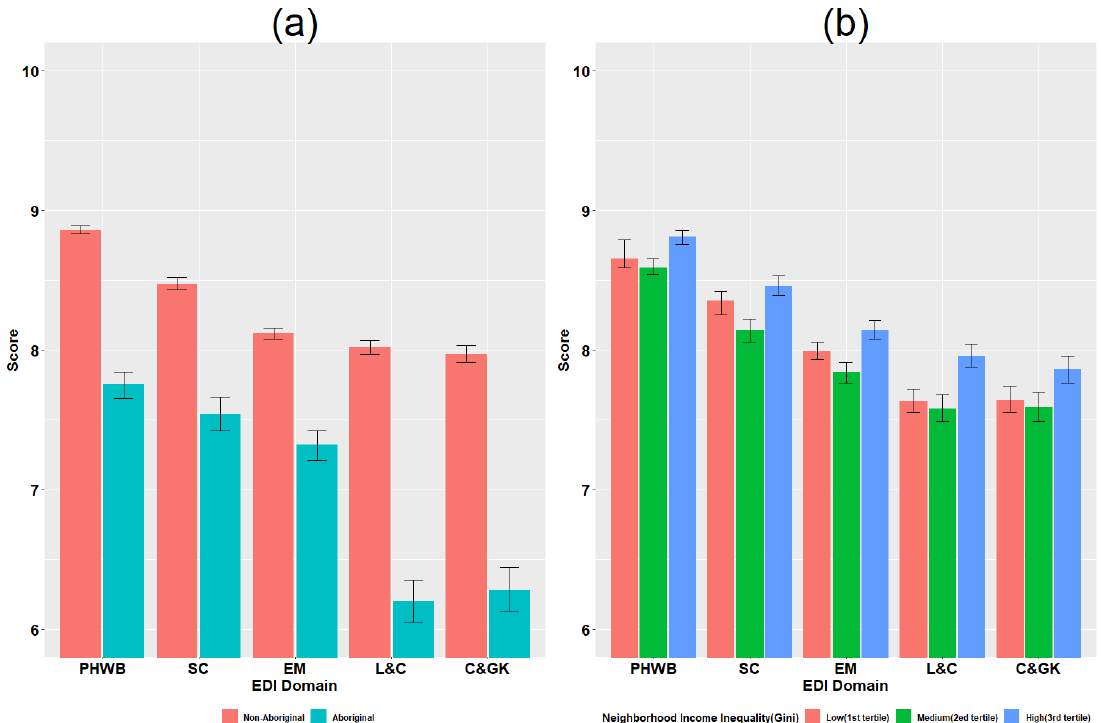
Figure 1. EDI scores by Aboriginal / non-Aboriginal status and neighborhood income inequality. ( a ) compares mean EDI scores and 95% confidence intervals by EDI domain for Aboriginal versus non-Aboriginal children. ( b ) compares mean EDI scores and 95% confidence intervals by EDI domain for neighborhoods of low, medium and high income inequality. Abbreviations: PHWB: physical health and well-being; SC: social competence; EM: emotional maturity; L&C: language and cognitive development; C & GK: communication and general knowledge.